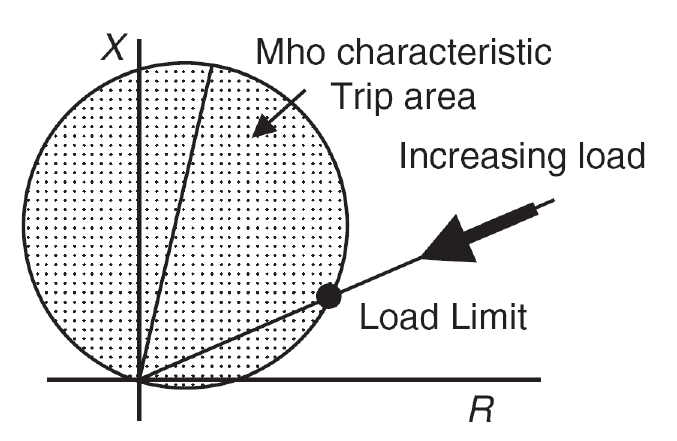
Figure 1. Mho Relay Characteristic